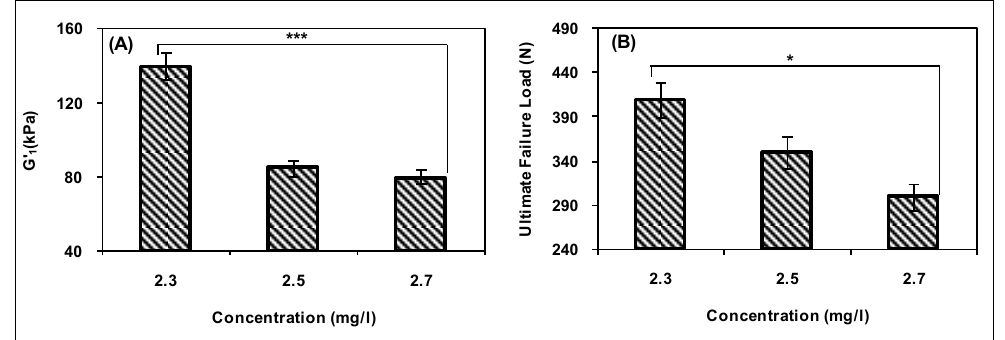
Figure 6. Effect of paste concentration on (A) fracture point and (B) ultimate failure